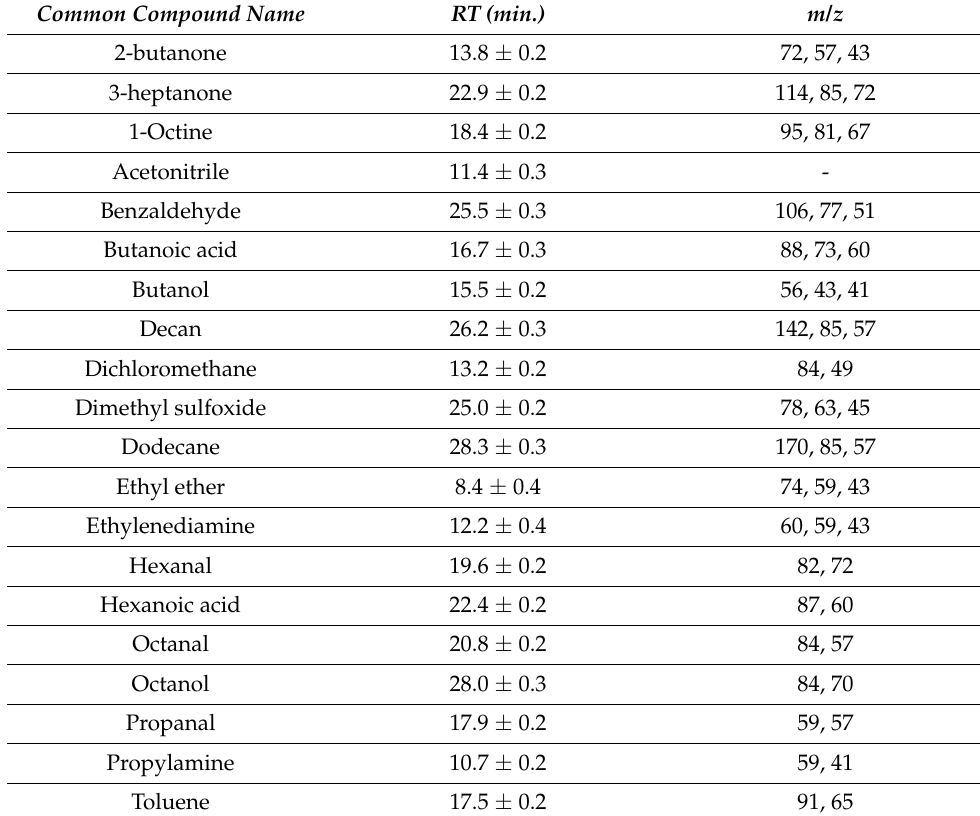
Table 3. Selected VOCs RTs and m / z